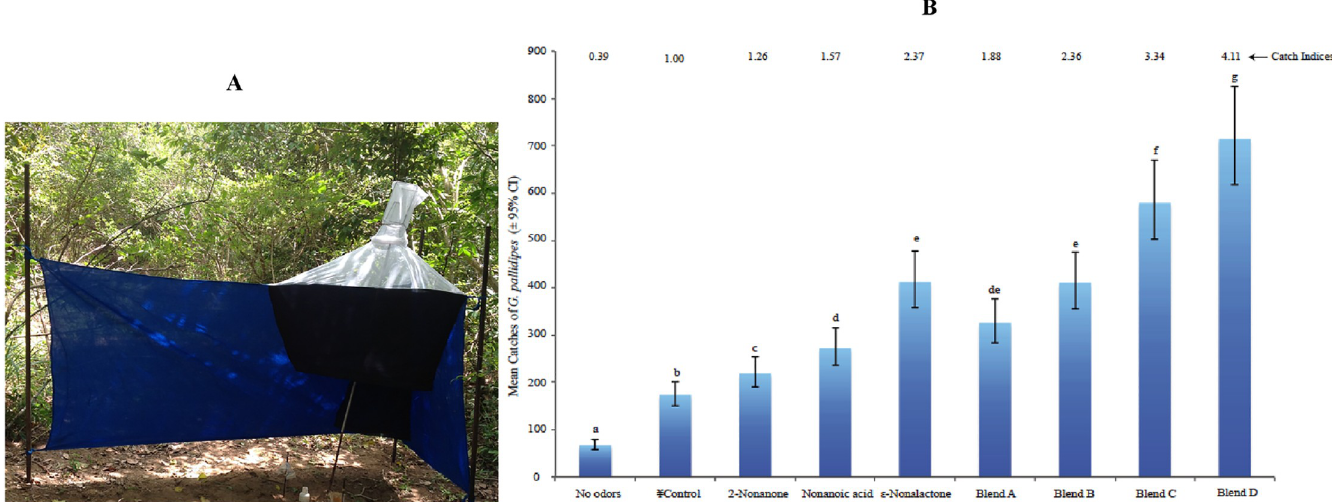
Fig 2. A: A photograph of NG2G trap for evaluating relative attraction of tsetse flies to chemical odors. B: Relative mean field catches of G . pallidipes to attractant baited NG2 G traps. ¥ Trap baited with fermented cow urine and POCA; means followed by the same letter are not significantly different ( p > 0.05, LSD post-hoc analyses); Catch index = total mean catches expressed as proportion of that of control